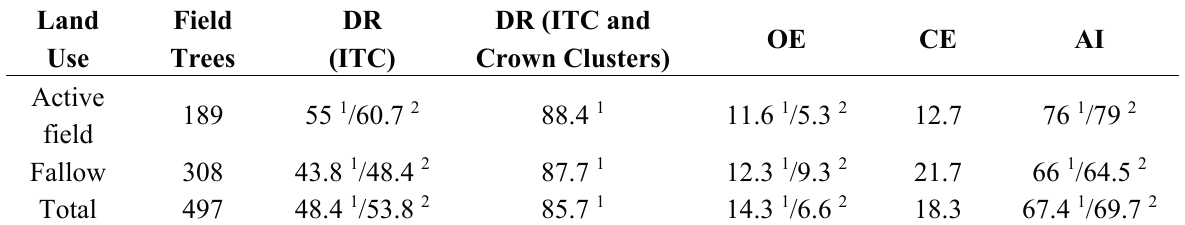
Table 7. Results of detection accuracy assessment showing detection rate (DR; %), omission error (OE; %), commission error (CE; %) and accuracy index (AI; %).